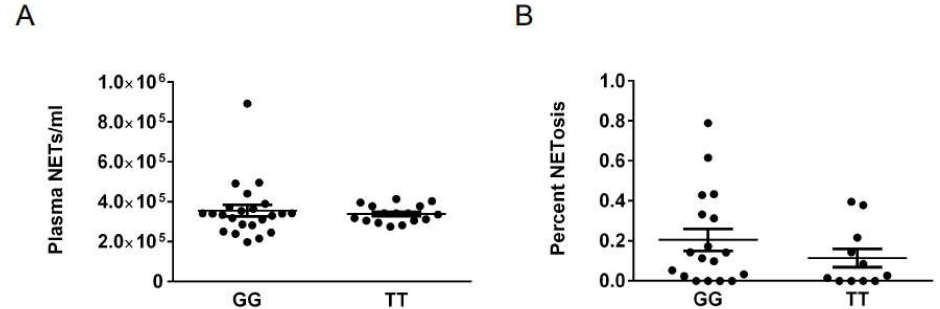
Figure 1. Genotype at rs2240335 does not significantly correlate with NET levels. ( A ) Circulating NET levels measured in the plasma of control subjects by ELISA were compared for homozygotes for the G and T alleles at rs2240335 by t -test. ( B ) Images of Sytox-stained peripheral blood neutrophils from control subjects allowed to NET for 4 h were analyzed for percent NETosis and compared for homozygotes for the G and T alleles at rs2240335 by t-test. For all panels, mean and standard error of the mean (SEM) are graphed. No comparisons are significant. For ELISA, n = 23 GG and n = 16 TT. For in vitro NETosis, n = 18 GG and n = 11 TT.